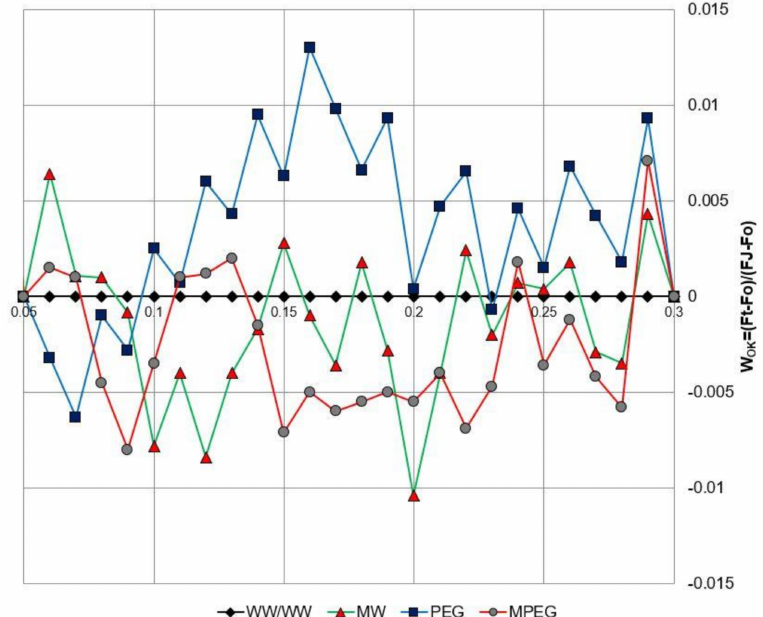
Figure 5. The L-band: Relative variable fluorescence W OK = (F t − F O ) / (F K − F O ) and di ff erences between the WW, MW, PEG, and MPEG plants under normal and PEG-induced osmotic stress conditions. Curves represent the di ff erence kinetics, ∆ W OK of the plants under normal and PEG-induced osmotic stress conditions on a logarithmic scale.